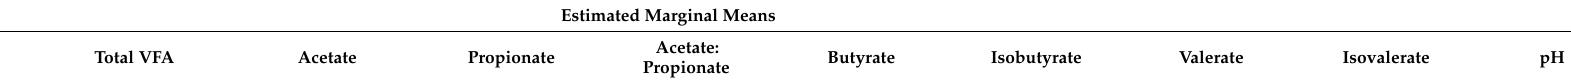
Table 5. Estimated marginal means (EMM) of volatile fatty acid (VFA) concentration and pH, of factors having a significant effect at 3 time-points ( − 7 d: 7 days pre-weaning, at 0 d: weaning, and 7 d: 7 days post-weaning) from 243 Holstein calves of eight commercial dairy